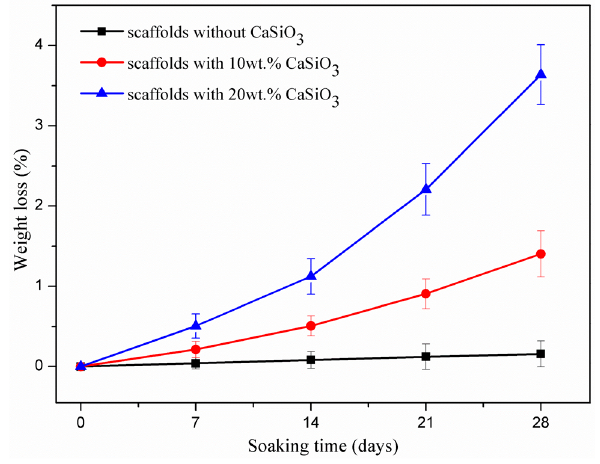
Figure 6. Weight loss of the scaffolds in phosphate buffer saline (PBS) solution.